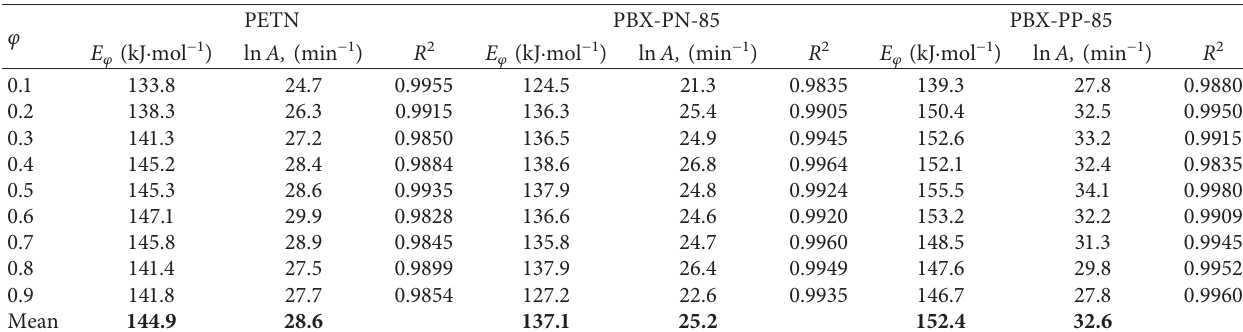
Figure 3: Isoconversional plots at selected conversion degree of PETN, PBX-PN-85, and PBX-PP-85 according to the modified KAS method. Table 4: Kinetic parameters of PETN and PBXs by the modified KAS